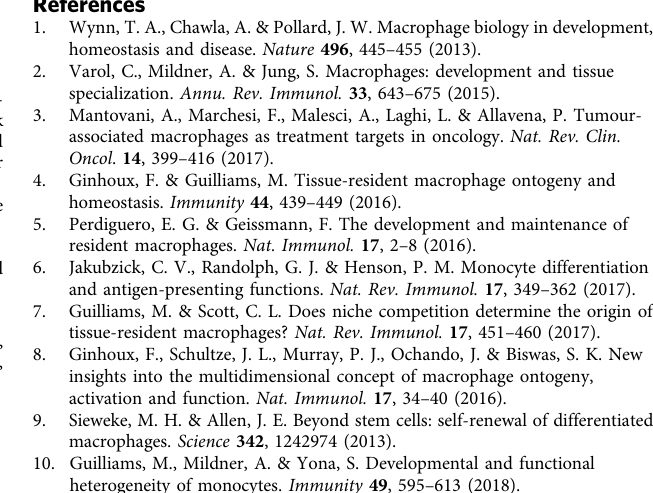
Table 1 for 30 min at room temperature. After washing with PBS (Gibco, cat. 18912-014) the sections were mounted with ProLong Gold Antifade Mountant with DAPI (4 ′ ,6-diamidino-2-phenylindole; Thermo Fisher Scienti fi c, cat. 62249),